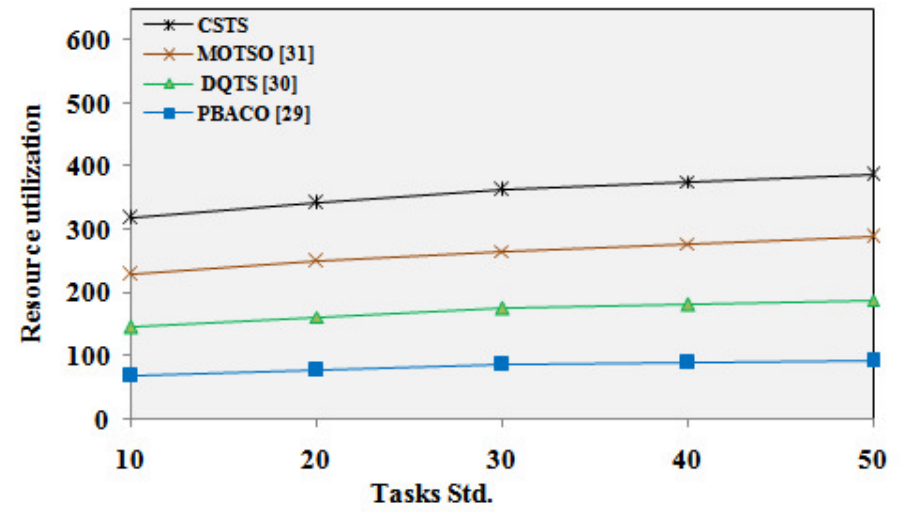
Figure 9. Resource utilization with task standard